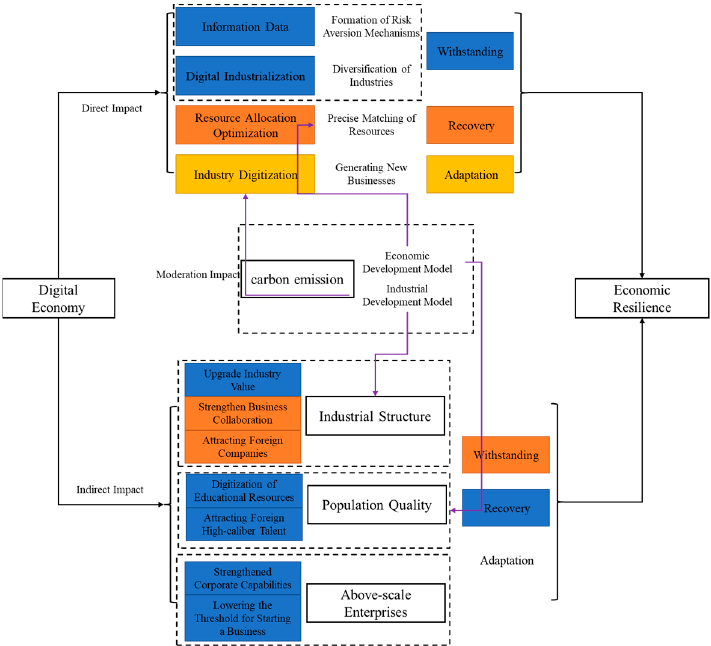
Figure 1. Pathway illustrating the impact of digital economy on urban economic resilience.